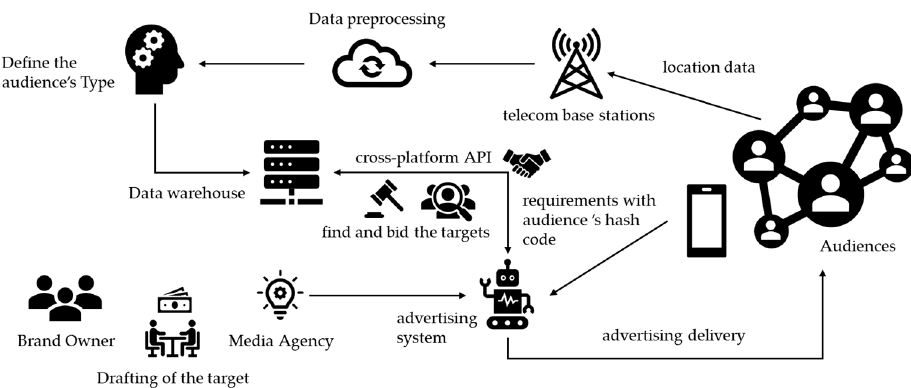
Figure 6. System scope in the study.